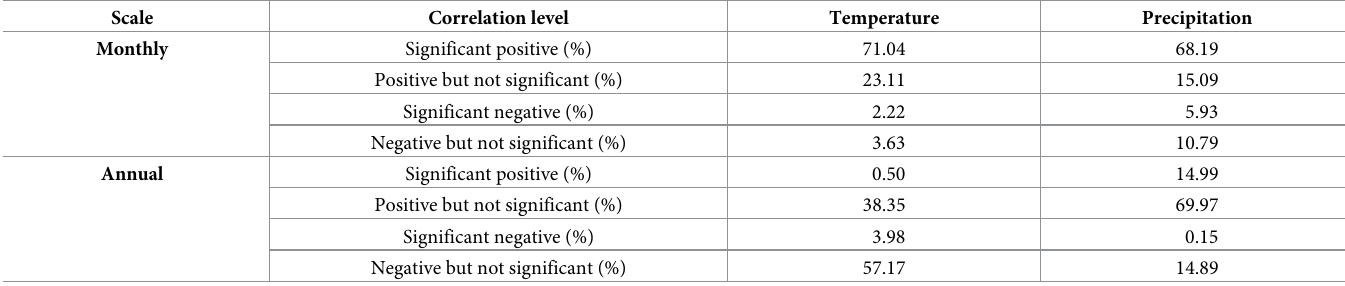
“Significant positive” denotes pixels r > 0 and p < 0.05, “Positive but not significant” denotes pixels r > 0 and p > 0.05, “Significant negative” denotes pixels r < 0 and p < 0.05, and “Negative but not significant” denotes pixels r < 0 and p >